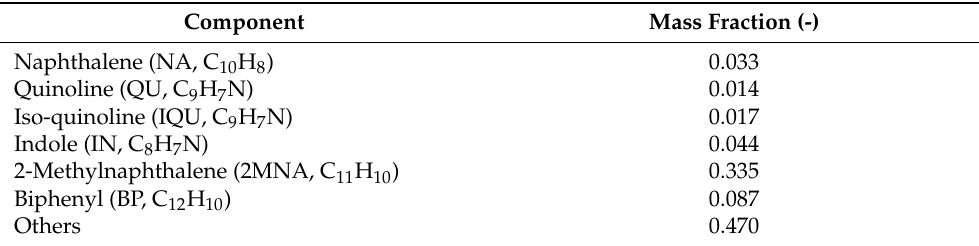
Table 2. Composition of feed (wash